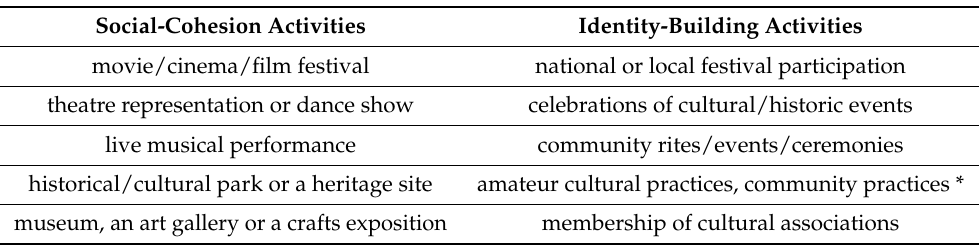
Table 5. Activities and services identified as essential to maintain the functionality of HAs and the well-being and economies of local communities (adapted from Agenda|Culture